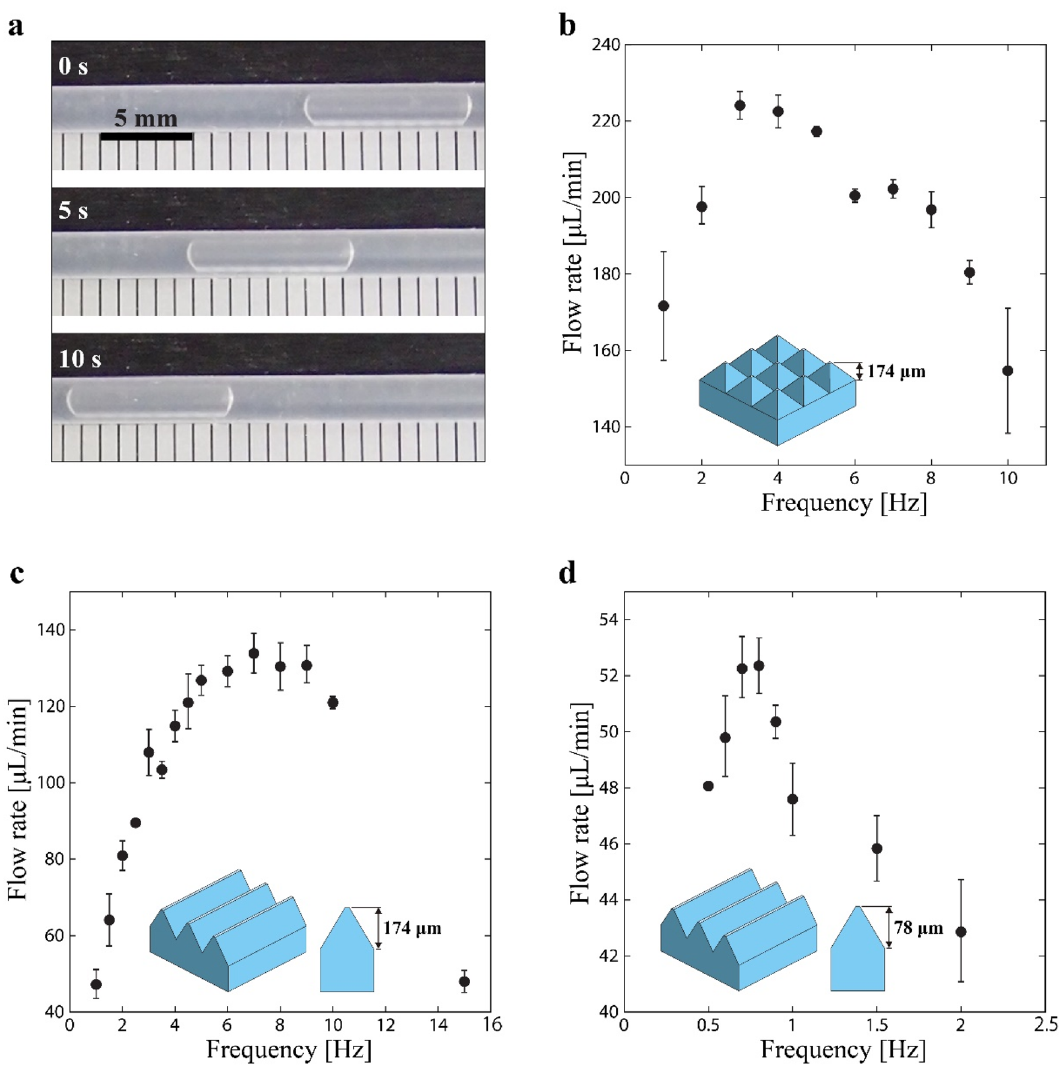
Figure 6. ( a ) Liquid flow generated by the PVC gel pump based on the observed bubble in the silicone tube. ( b ) Measured flow rate as a function of the driving frequency for the pump with a pyramid-patterned gel sheet (applied voltage 800 V). ( c ) Measured flow rate as a function of the driving frequency for the pump with a ridge- patterned gel sheet (applied voltage 800 V, height 174 µm). ( d ) Measured flow rate as a function of the driving frequency of the pump with ridge-patterned gel sheet (applied voltage 800 V, height 78 µm). For the measured flow rates, average of three times measurement is of the PVC gel sheet with the pyramid pattern (height = 174 µm) is 115 µm, which corresponded to a flow volume per pumping of 9.2 µL. For the gel sheets with ridge patterns of height 174 and 78 µm, the calculated maximum flow volume per pumping was 6.9 (max. disp. 82 µm) and 2.9 µL (max. disp. 33 µm), respectively. These values are consistent with the measured flow rates shown in Fig. 6 as well as the measured displacement in the thickness direction shown in Fig. 4. As for other factors, the PVC gel sheet with the pyramid pattern (height = 174 µm) has a larger displacement in the thickness direction (Fig. 4), so the overall amount of liquid to be extruded is larger. As the frequency is increased, the amount of deformation gradually decreases because the deformation of the gel cannot match the input. In this regard, the flow rate is determined by the multiplication of the fre- quency and the amount of deformation at that time. The frequency at which the flow rate peaks is 3 Hz for the pyramid pattern. For the ridge pattern with height of 174 µm, the overall flow rate is lower due to the relatively small displacement in the thickness direction. Alternatively, the peak frequency takes a higher value of 7 Hz for two potential reasons. The first is that a smaller displacement increases the frequency at which the maximum displacement can be leveraged, because the time required to reach that displacement is much shorter. The sec- ond is the ratio between the volume of the pattern and its surface area (the area in contact with the liquid). The larger the volume that can be actively deformed relative to the surface area, the easier it is to push the liquid out, thus increasing the frequency. In a 500 µm square unit on a PVC gel sheet, the 174 µm high ridge pattern has a surface area of 3.83 × 10 –5 µm 2 and a volume of 2.34 × 10 –7 µm 3 , which gives a volume per unit surface area of